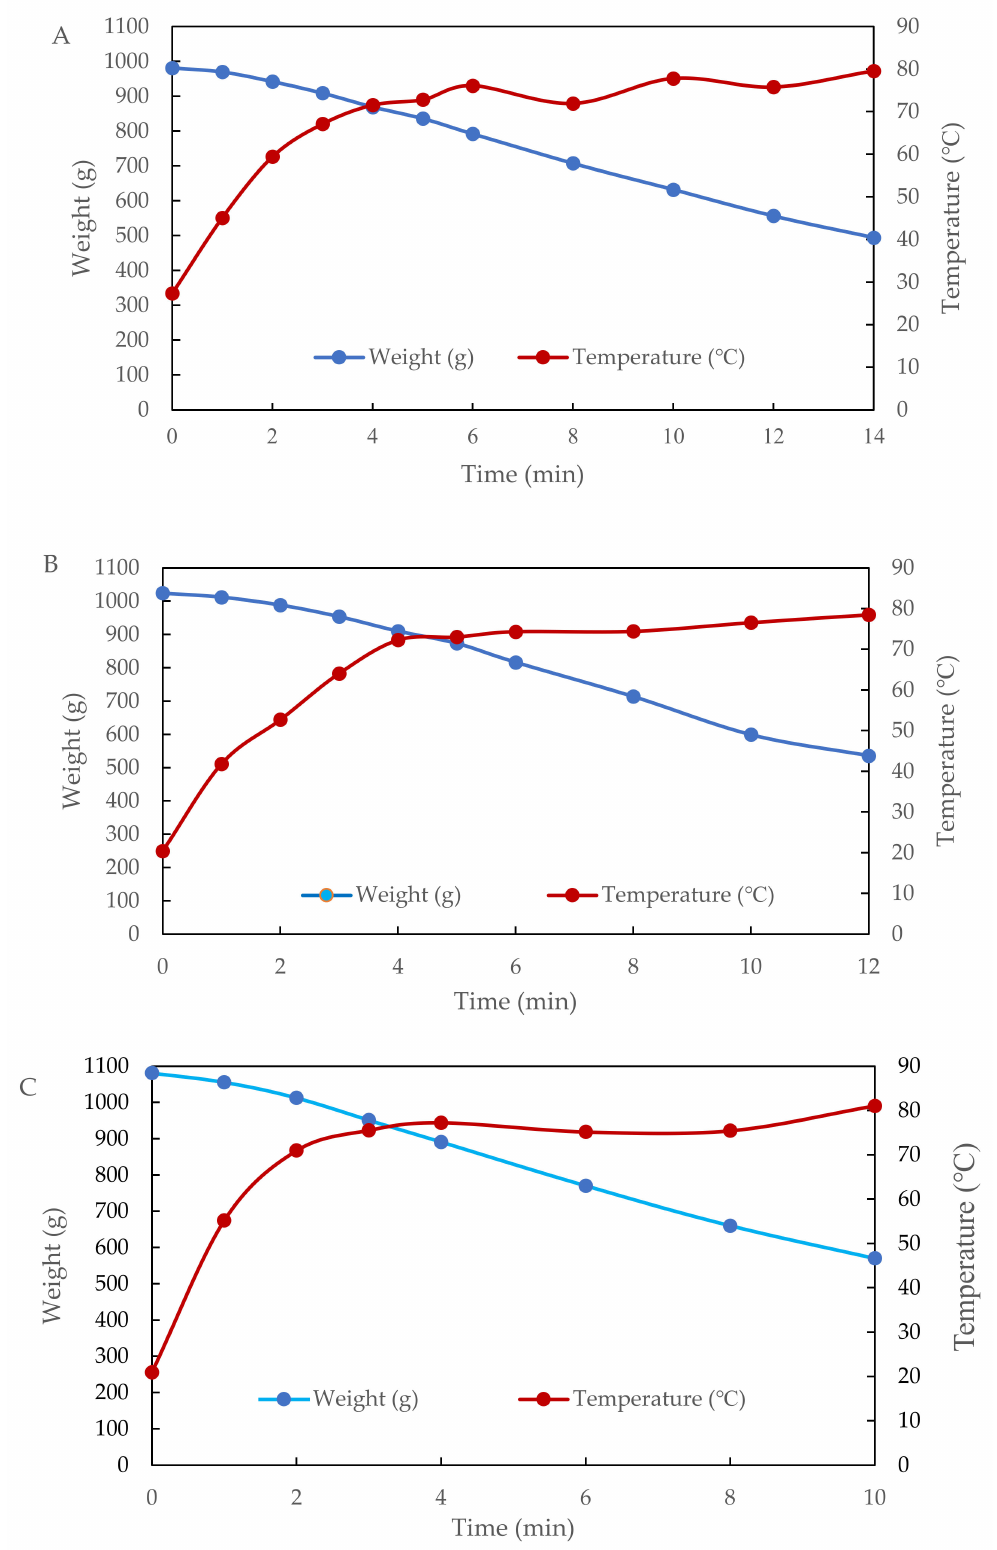
Figure 2. Temperature profiles and drying curves of wild bitter gourd extract mixed with soybean fiber: ( A ) 2:1, ( B ) 2:1.1, and ( C ) 2:1.2 during HARF